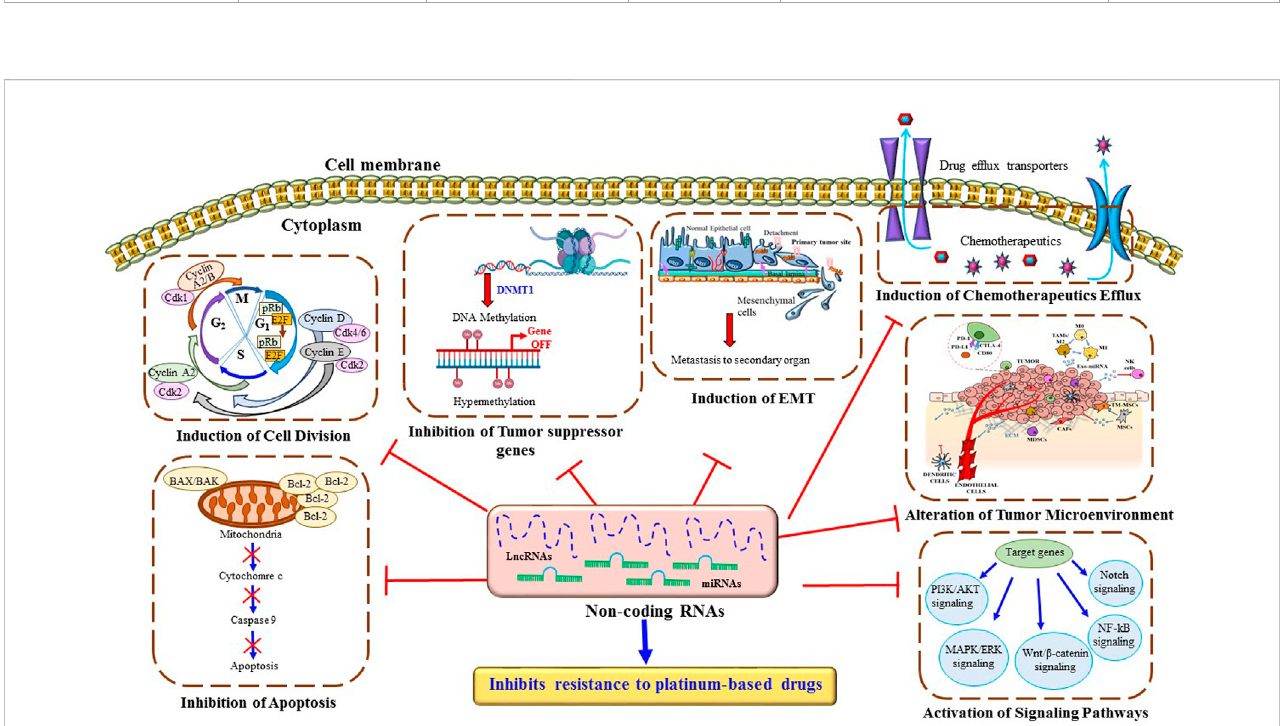
FIGURE 4 Major mechanismsthroughncRNAs inhibit resistance to platinum-based drugs inlung cancer cells. ncRNAs regulate multiple cellular mechanisms such as drug ef fl ux, DNA repair pathways, intrinsic and extrinsic cell death programs, cell cycle, metastasis, and several signaling pathways, which contribute to platinum-based drug resistance in lung cancer